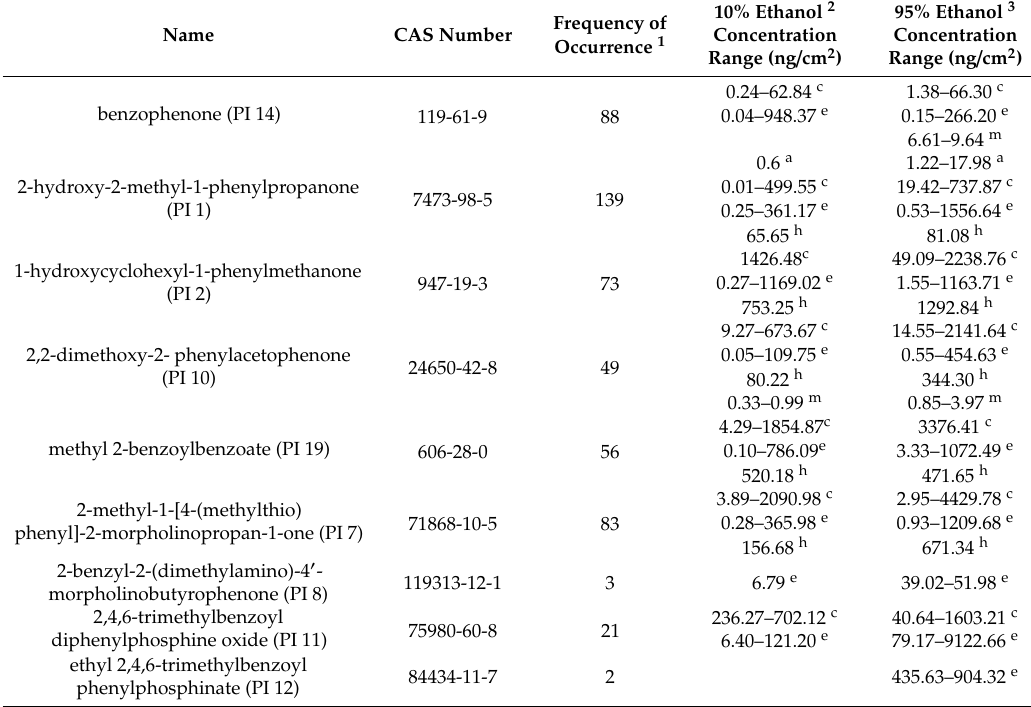
Table 3. Frequency of Occurrence and Concentration Range of PI’s and Photolytic Decomposition Products.